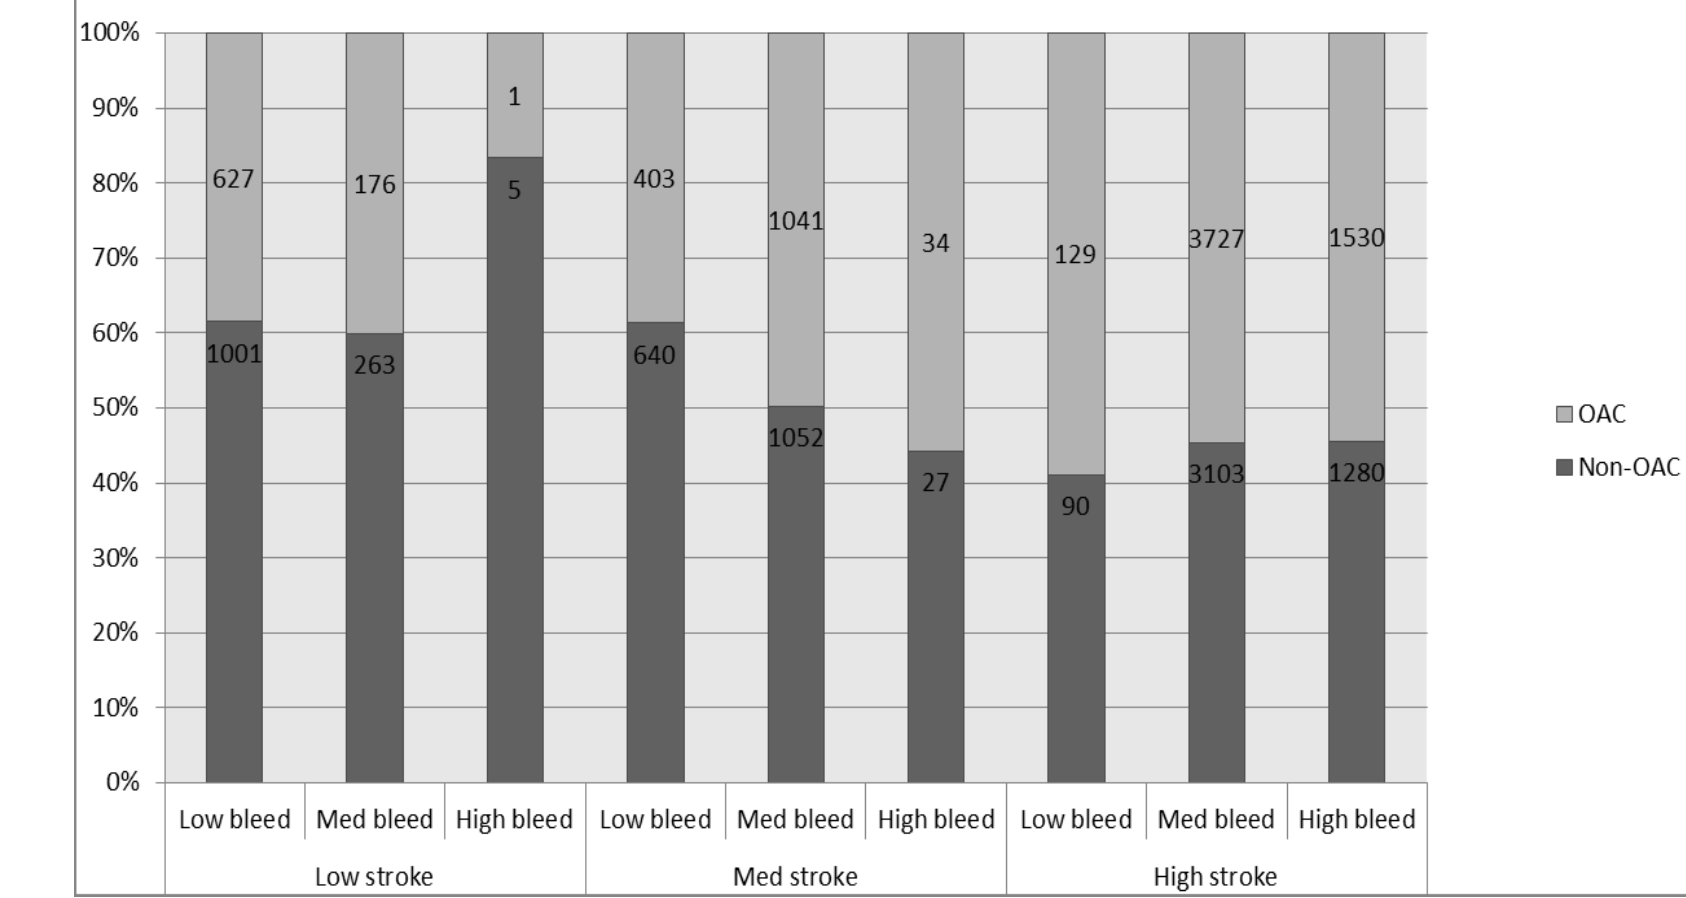
Figure 1. Actual OAC use: Number of patients that received and did not receive OAC stratified by stroke and bleeding risk scores. * Data shown are the number of patients who were exposed to OAC/non-OAC within 90 days after index diagnosis. Low stroke: CHA 2 DS 2 -VASc score = 0, Med stroke: CHA 2 DS 2 -VASc score = 1, high stroke: CHA 2 DS 2 -VASc score ≥ 2, Low bleed: HAS BLED score = 0, Med bleed: HAS BLED score = 1 or 2, high bleed: HAS BLED score ≥